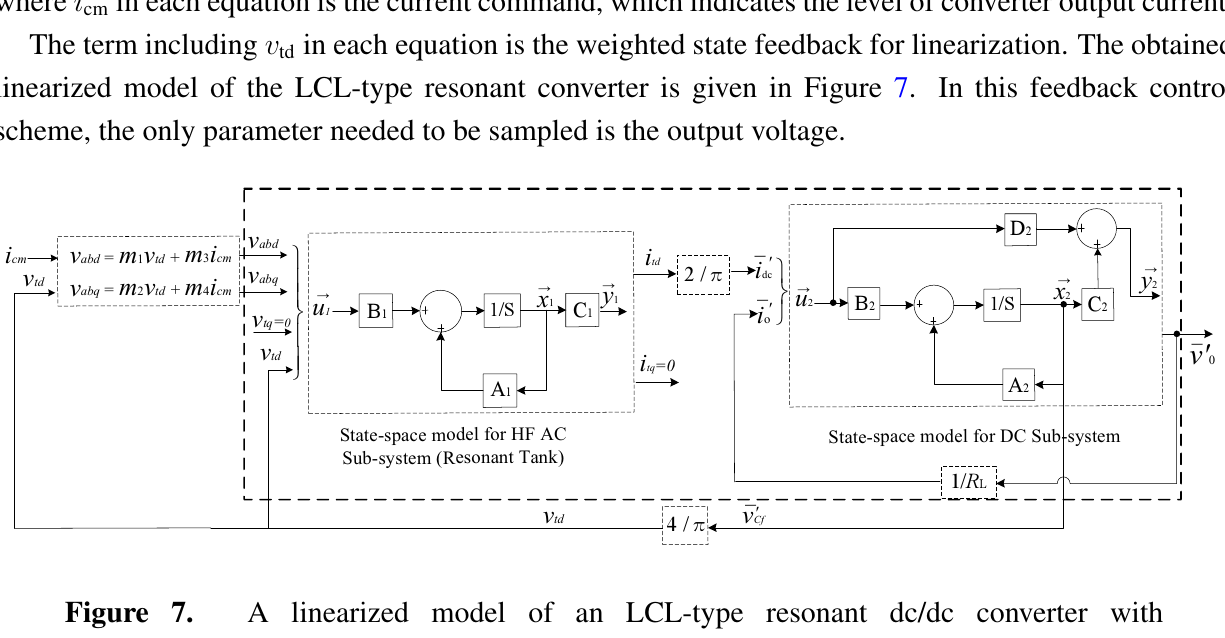
A linearized model of an LCL-type resonant dc/dc converter with feedback